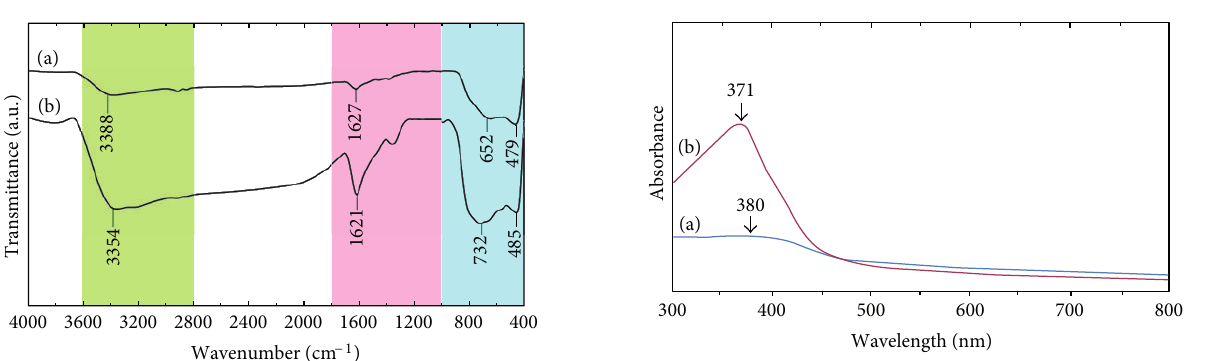
F 5: Fourier transform infrared spectra for samples A and B of TNPs ((a) and (b)).